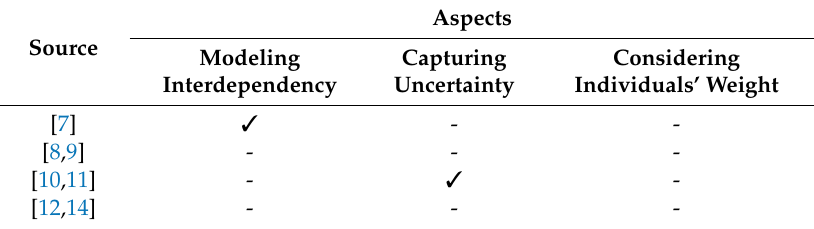
Table 2. A summary of the risk maturity models for construction